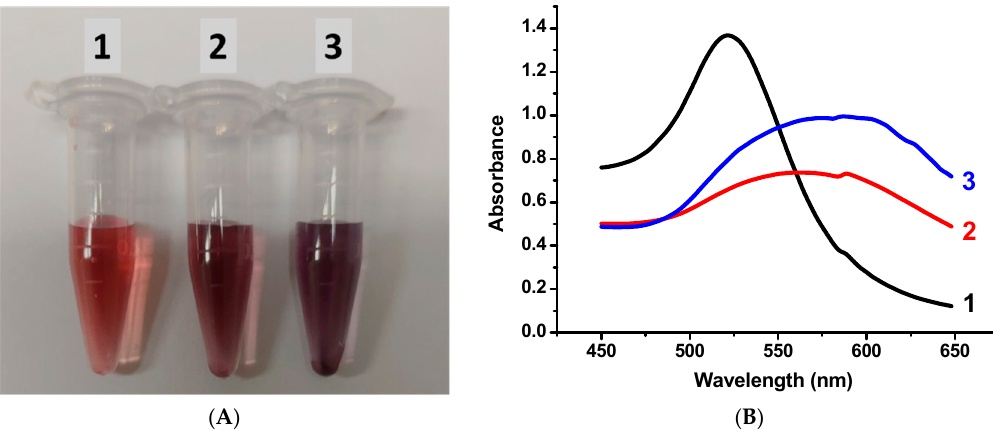
Figure 4. Aggregation of the GNPs conjugates. ( A ) The appearance of colloidal solutions, 1 is the initial solution of the nanoparticles, 2 is the colloidal solution after adding 10 μ g/mL of Mab2H3C6 centrifuged six times through the 10 kDa Amicon Ultra filters, 3 is the colloidal solution after adding fraction of 10–30 kDa. ( B ) The absorbance spectra of 1–3 solutions.